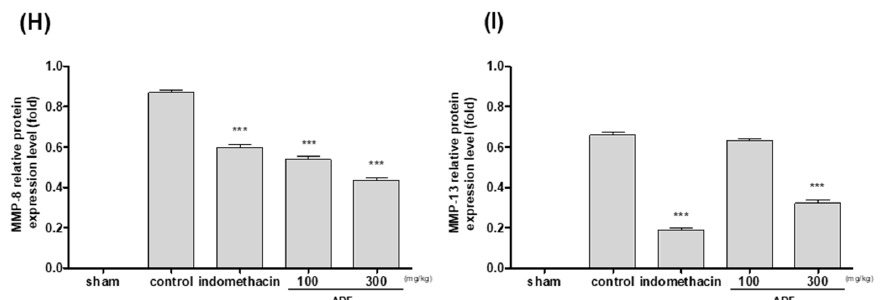
Figure 5. Changes of matrix metalloproteinase (MMP) at knee joint cartilage tissue with Andrographis paniculata extract (100 and 300 mg / kg) treatment. mRNA expression of MMP-1, MMP-3, MMP-8, and MMP-13 ( A – D ) determined by quantitative Real Time PCR. ( E – I ) Protein expression of MMP-1, MMP-3, MMP-8, and MMP-13 measured with Western blot analysis. * p < 0.05 vs. control, ** p < 0.01 vs. control, *** p < 0.001 vs. control by one-way ANOVA, Dunnett’s test.